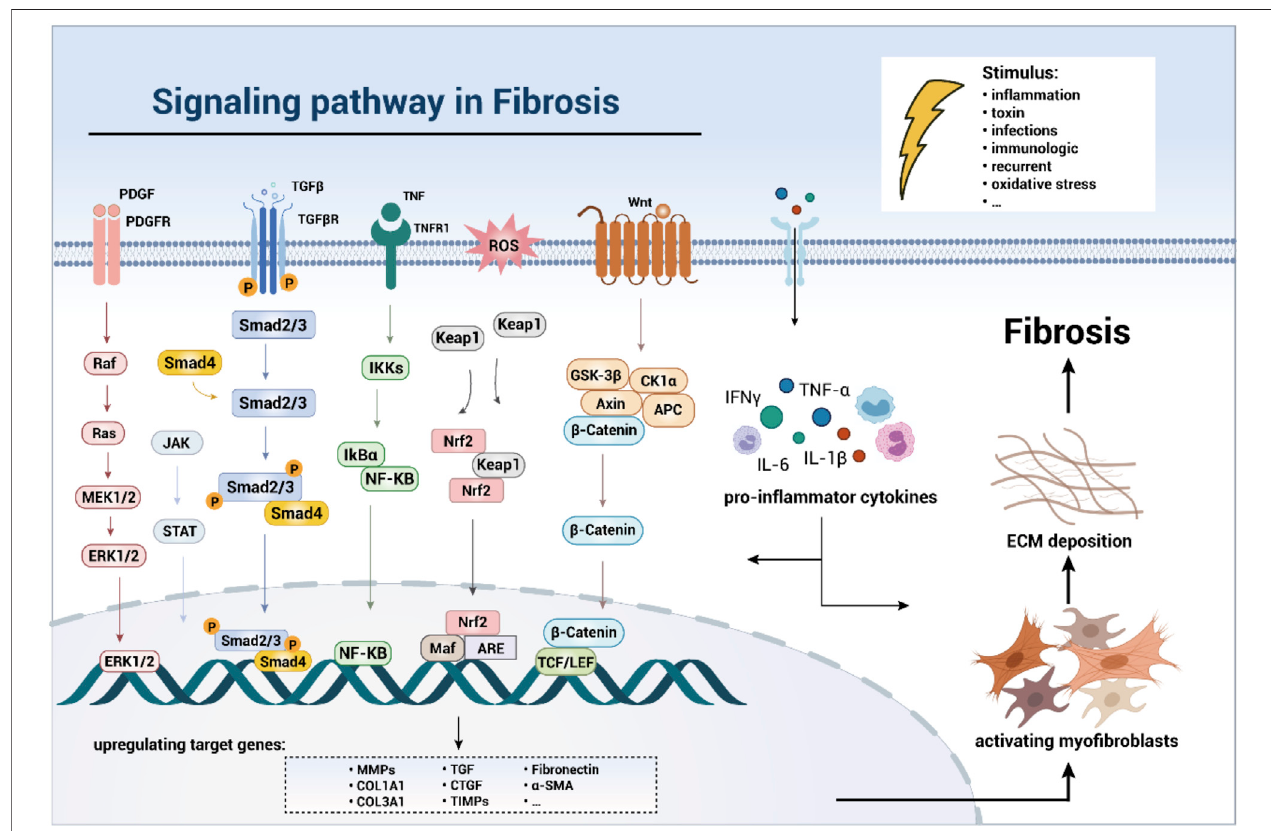
FIGURE 2 | Schematic diagram of the interaction of pro fi brotic signaling